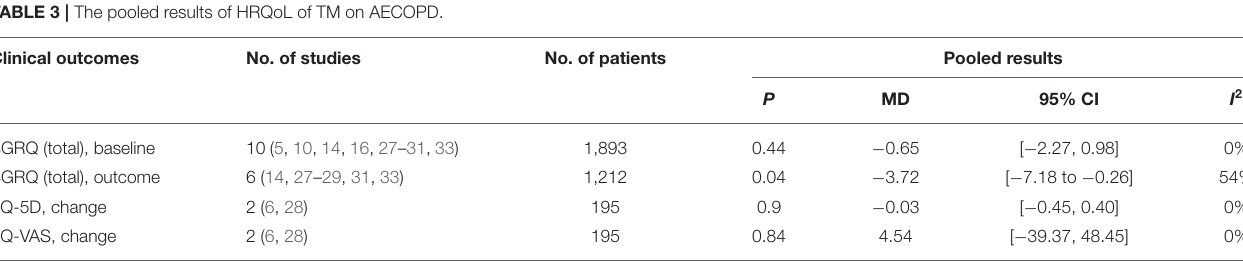
TABLE 3 | The pooled results of HRQoL of TM on AECOPD. Clinical